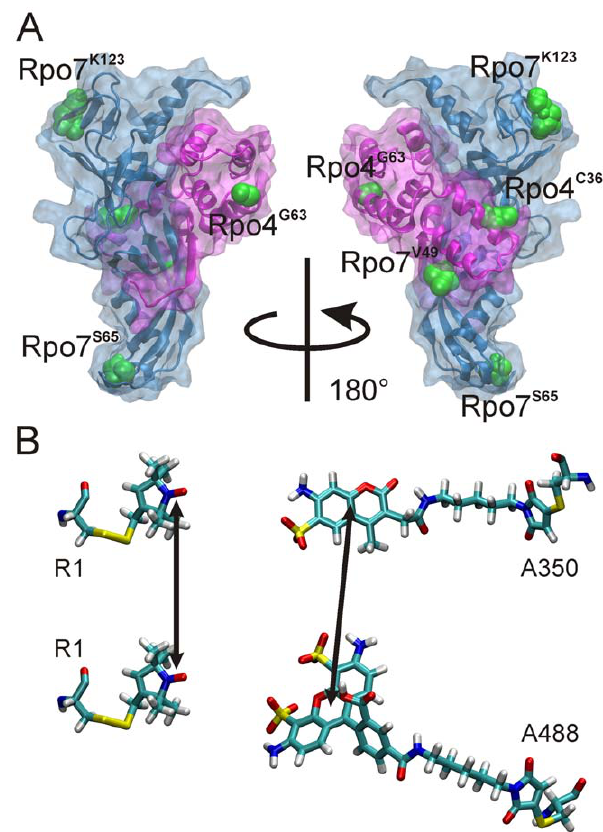
Figure 1. The model system. (A) Crystal structure of the Rpo4/7 complex (pdb: 1GO3) with the positions used for labeling indicated by a spacefill representation of the native side chains (green). (B) Structures of a spin label pair (left) and the fluorophore pair used in this study. The arrows indicate where the electronic orbitals are between which inter label distances are measured. In first approximation for spin labels this is the center of the nitroxide N-O bond, for fluorophores the center of the chromophore region.